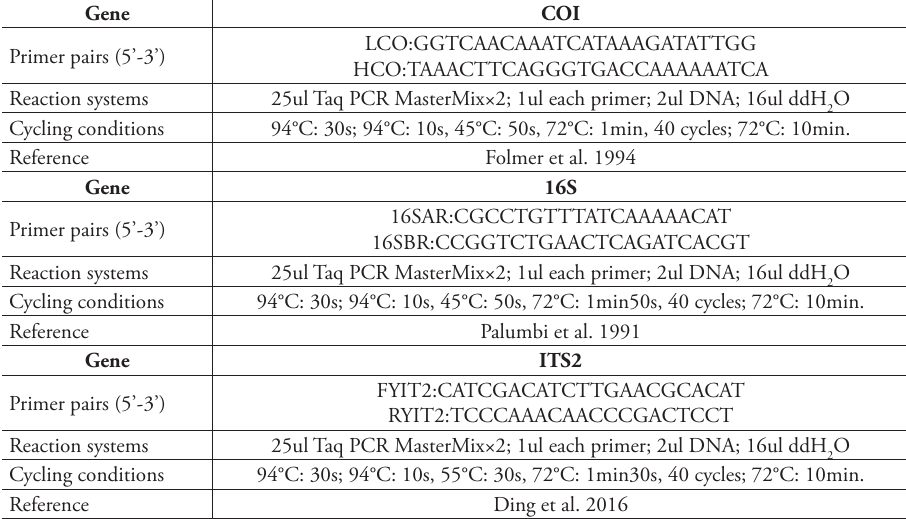
Table 1. Primer pairs and PCR conditions used in the analyses of the COI, 16S rRNA, and ITS2 genes of Camaena